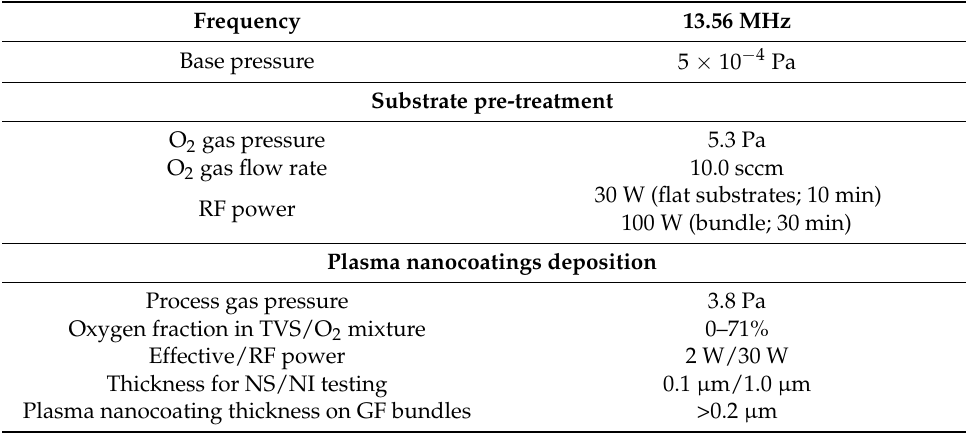
Table 1. Deposition